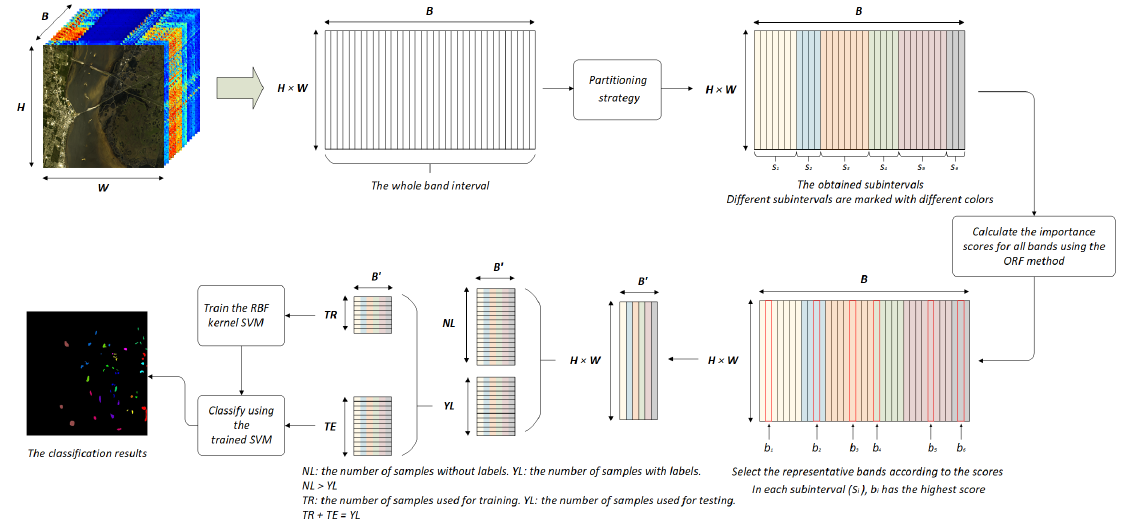
Figure 1. Structure of the proposed model for HSI dimensionality